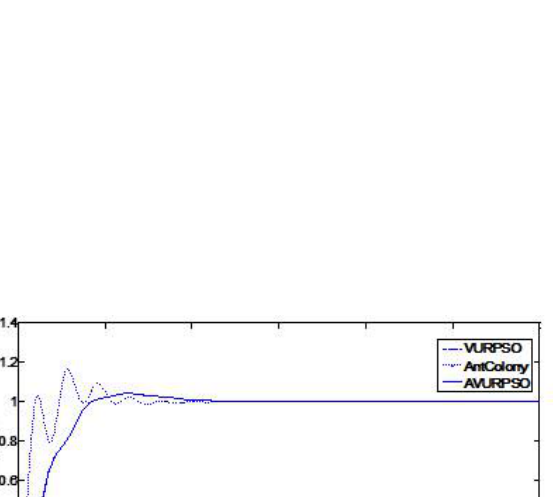
Figure 5: Comparing the VURPSO and AVURPSO on speed of conver- gence in Example 2.